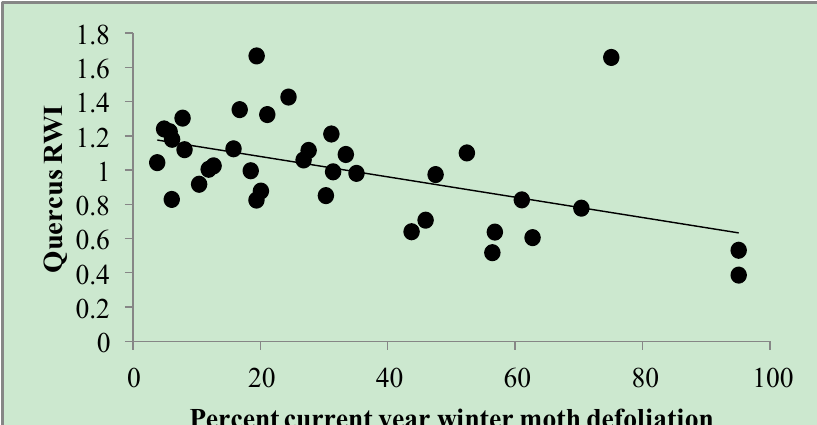
Figure 1. Quercus RWI by percent current year winter moth defoliation . Defoliation estimates ( n = 37) among eight trees throughout eastern Massachusetts from